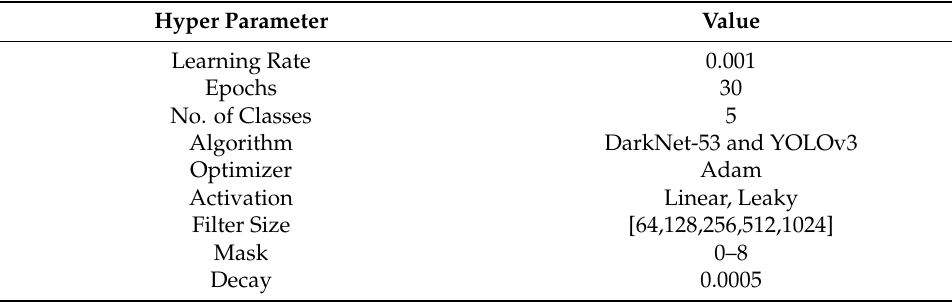
Table 3. Parameters and values for environment setup.